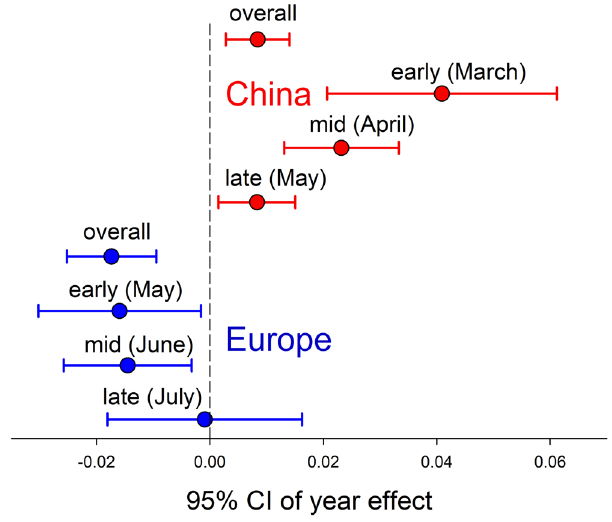
Fig. 2 The temporal change in early, mid and late season wheat aphid loads (log transformed) from 1970 to 2017 in China and Europe (95% con fi dence interval of